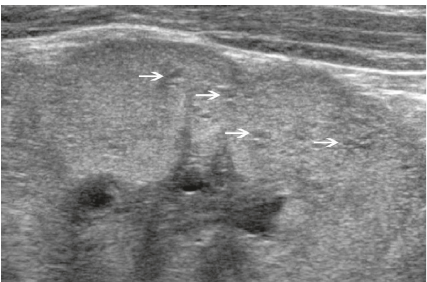
Figure 1: Ultrasound image of hyperechogenic kidney structure with multiple small cysts (white arrows) in the renal